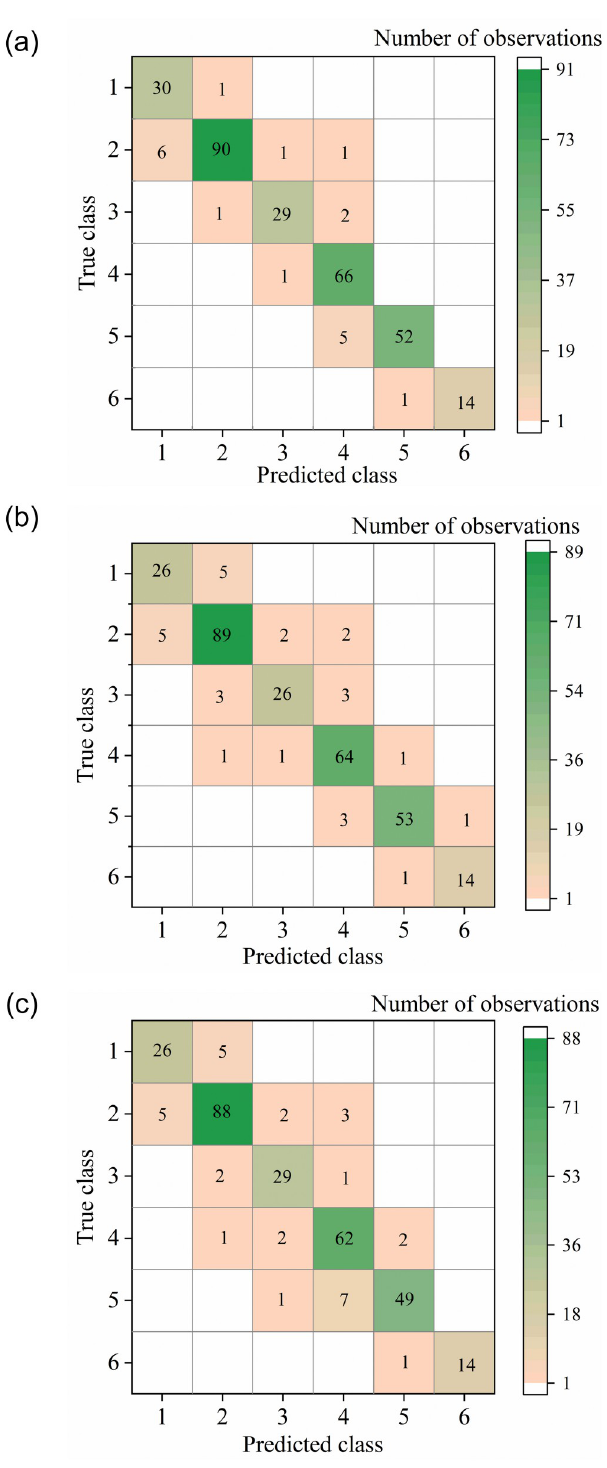
Fig 14. Confusion matrix for classification models training. Classification mistakes mainly happen between scheme 1 and scheme 2 and between scheme 4 and scheme 5. (a): Cubic SVM. (b): RF. (c): Weighted KNN.